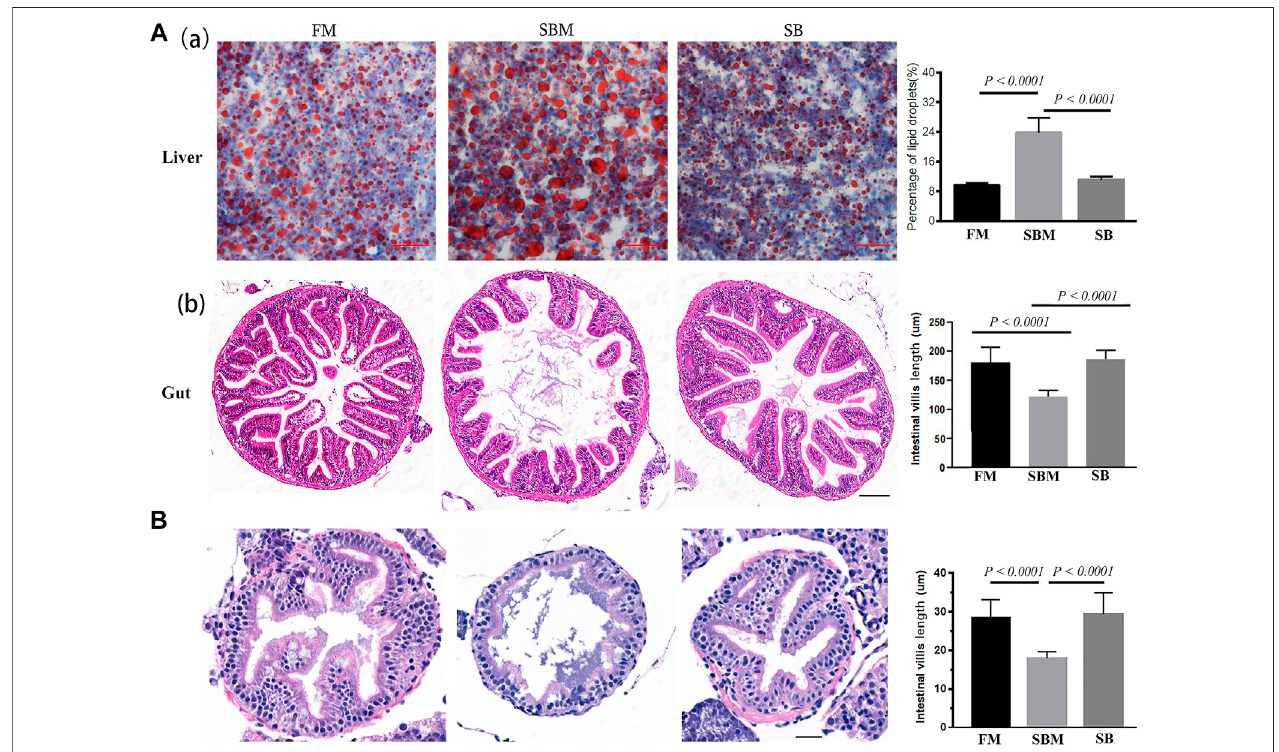
FIGURE 1 | Histological analysis of seabuckthorn ’ s effect pathologically. (A) In the SBMIE adult model, both decreased hepatic oil-red stained droplets (a) and increased length of intestinal villi (b) were found relieved in wide type zebra fi sh from the SB group compared to the SBM group. The scale bar in hepatic and intestinal images of adult zebra fi sh indicated 50 μ m. (B) HE staining of intestinal mucosa as well as quantitative analysis of intestinal villi length in 27 dpf wide type larva feed FM, SBM and SB diets. Scale bar: 20 μ m. FM: fi sh meal diet; SBM: soybean meal diet; SB: seabuckthorn supplementary SBM diet. All bar diagrams of quantitative analysis for hepatic oil red-stained signals or the intestinal villi length were at the right side of the typical images.